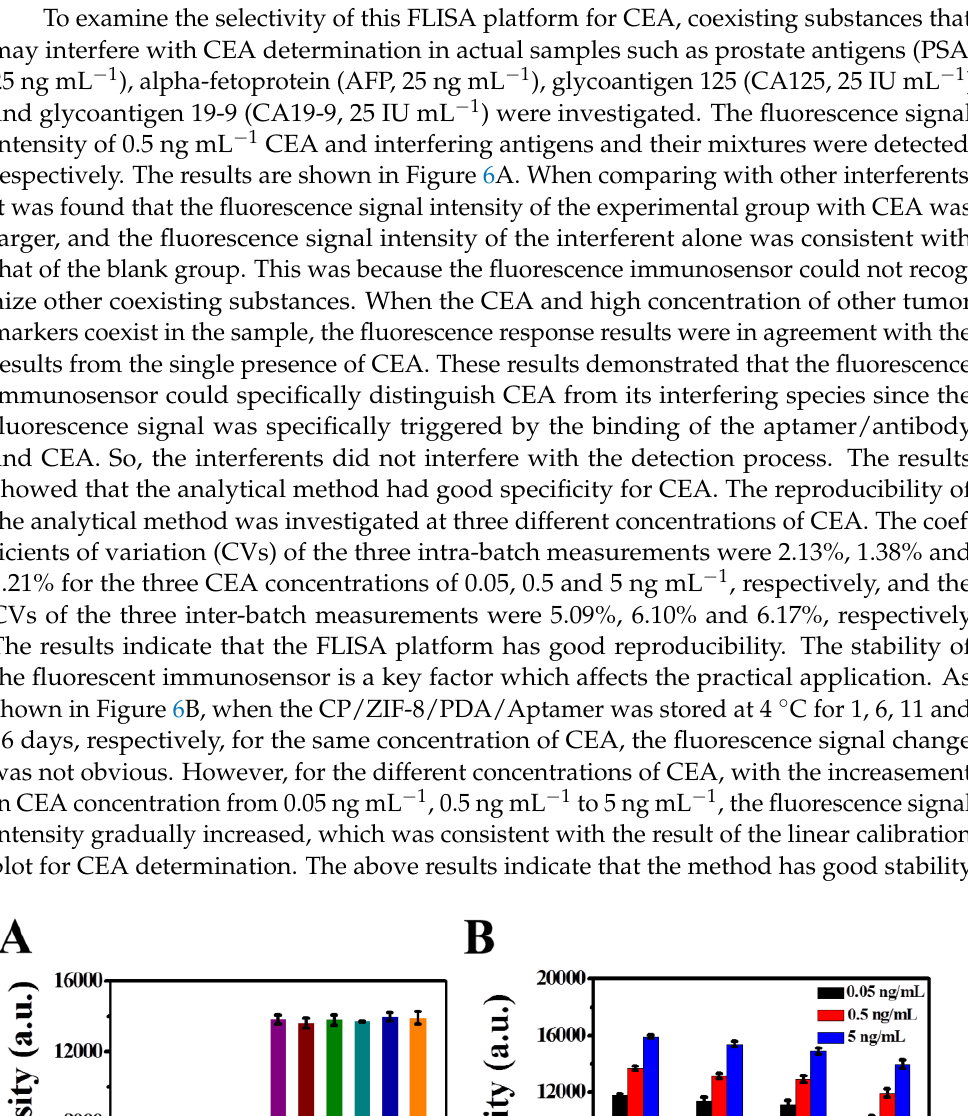
Table 1. Comparison of the results for the determination of CEA in clinical serum samples by using the self-supplied H 2 O 2 fluorescent immunosensor and the referenced electrochemiluminescence method. Sample Number Found by the Electrochemiluminescence Method [ng mL −1 ]